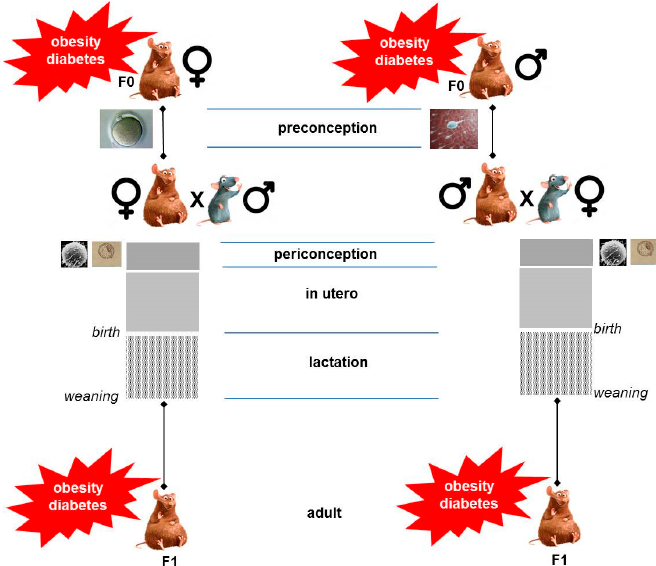
Figure 1. Parental contribution for programming adult obesity/diabetes in the offspring. The preconception (oocyte maturation, follicular development), conception (fertilization and embryo growth until implantation), gestational and suckling periods are critical time-windows for maternal obesity/diabetes (brown rodent) to shape the risk for the offspring to develop obesity or diabetes (left panel). The preconception period (sperm cell maturation) is a critical period for paternal obesity/diabetes (brown rodent) to shape the risk for the offspring to develop obesity or diabetes (right panel).